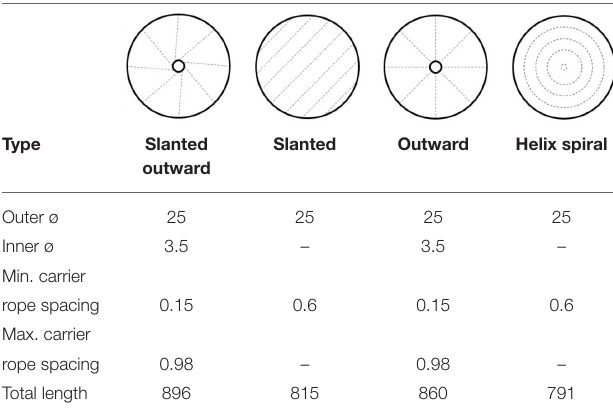
TABLE 2 | Wrapping